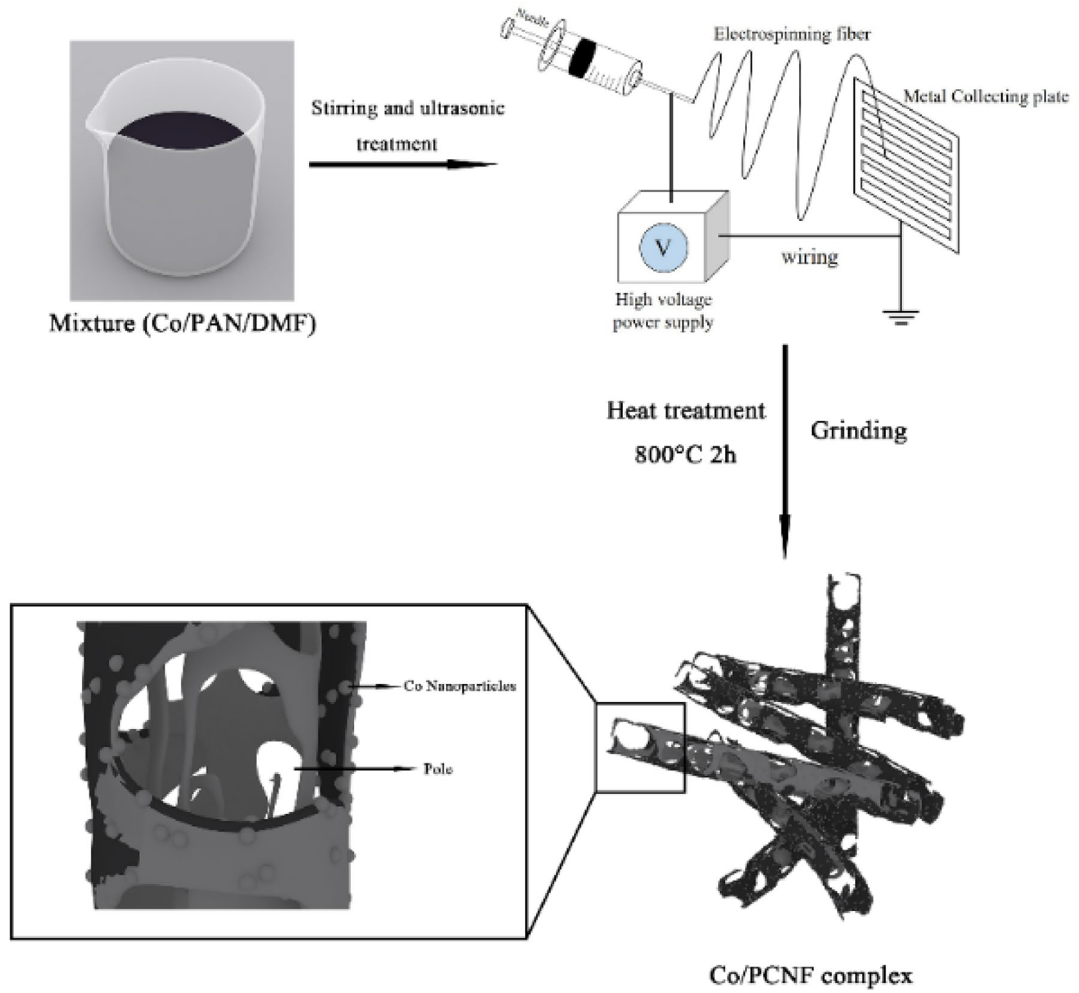
Figure 1. The schematic illustration of the fabrication process of